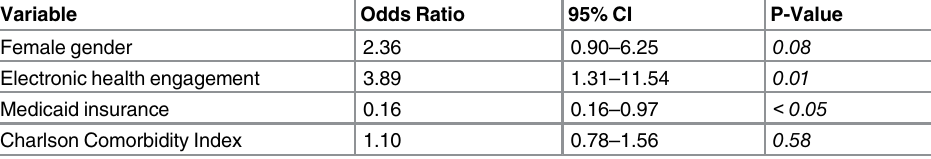
Table 5. Factors associated with treatment in hepatitis C virus positive